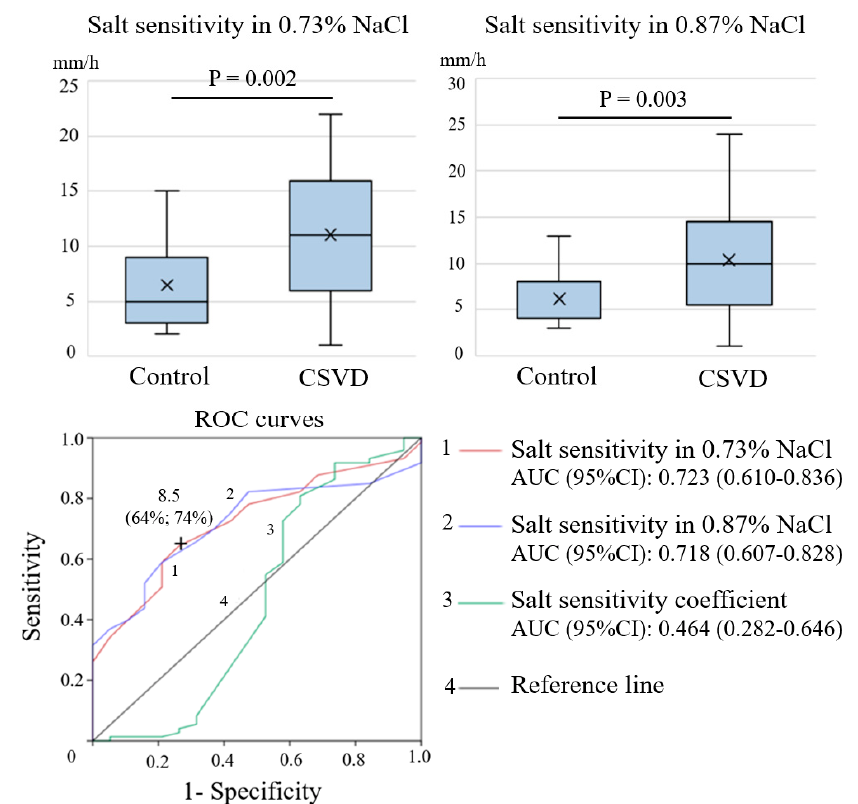
Figure 1. Comparison of the salt sensitivity parameters between patients with CSVD and the control group. Receiver operating characteristic (ROC) curves for salt sensitivity tests relative to CSVD development are shown.